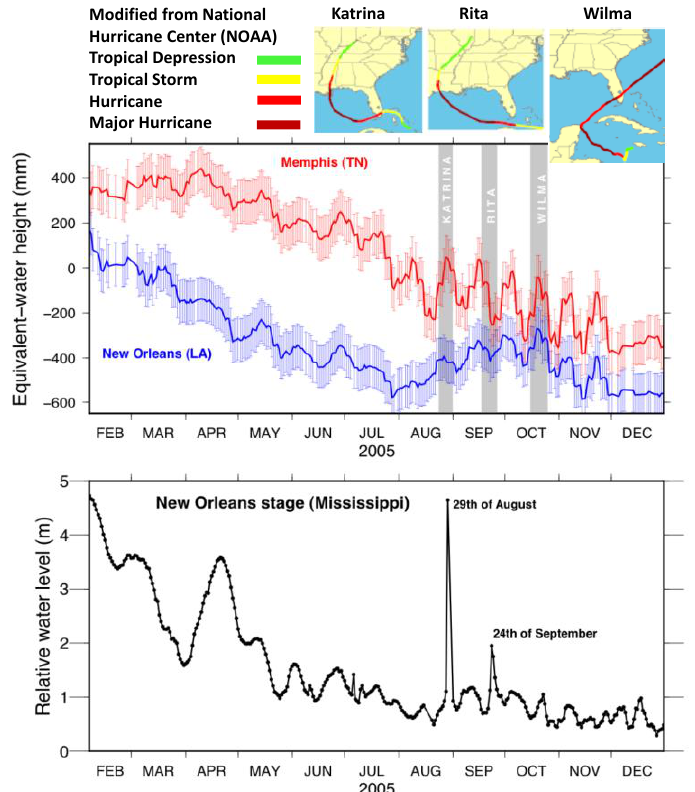
Figure 6. ( Top) Time series of EWH for surface tiles centered on the cities of New Orleans and Memphis extracted from the daily KF solutions. Error bars represent final uncertainties (about 0.1 mm for each triangular tile). The spin-up delay from cold start of the KF process is not represented here. The weekly periods of the main 2005 hurricanes during the cyclonic period (three-month bulge) are shaded. ( Bottom ) Historic daily records of Mississippi River level at New Orleans (Carrollton stage) collected by the Water Control Center, New Orleans District—US Army Corps of Engineers (http://rivergages.mvr.usace.army.mil/WaterControl/). Di ff erence maps of weekly averages of daily GRACE KF solutions and cumulated TRMM